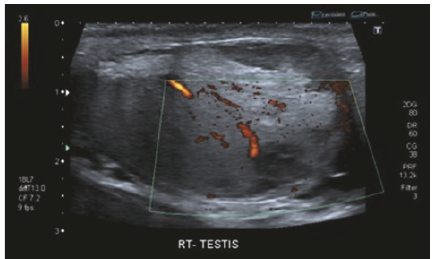
Figure 2: Fractured right testicle with Doppler flow to some areas on ultrasound scan.